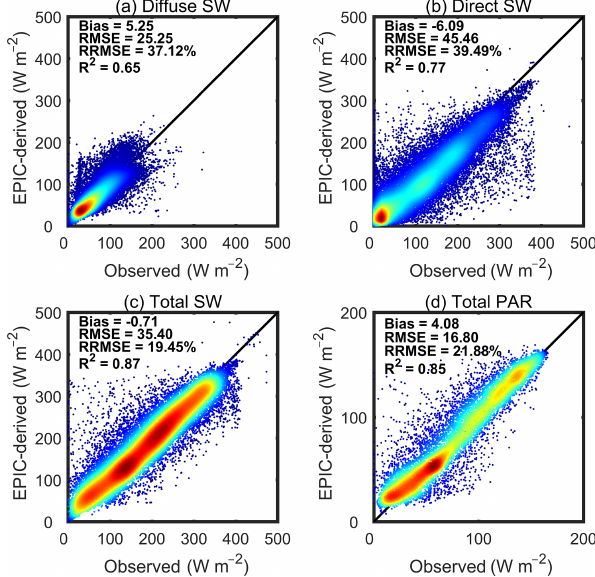
Figure 3. Evaluation of EPIC-based daily SW–PAR estimates against ground-based